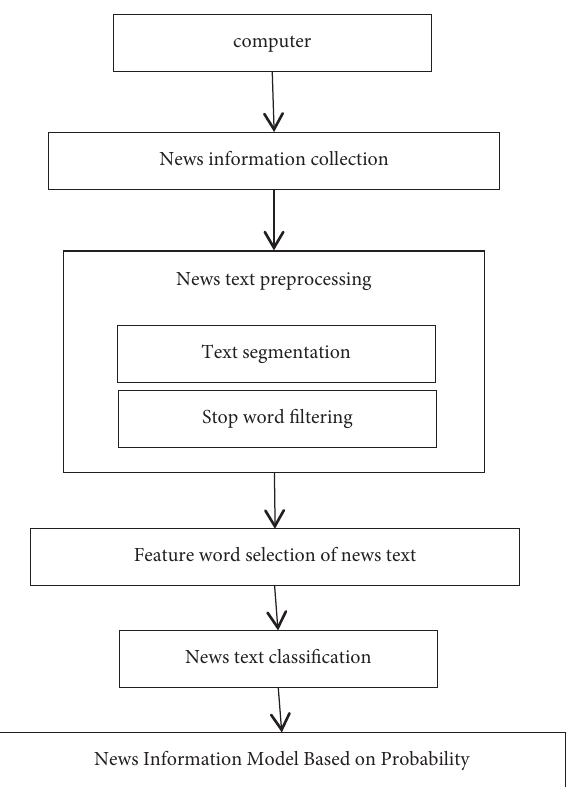
Figure 4: News information modeling steps.